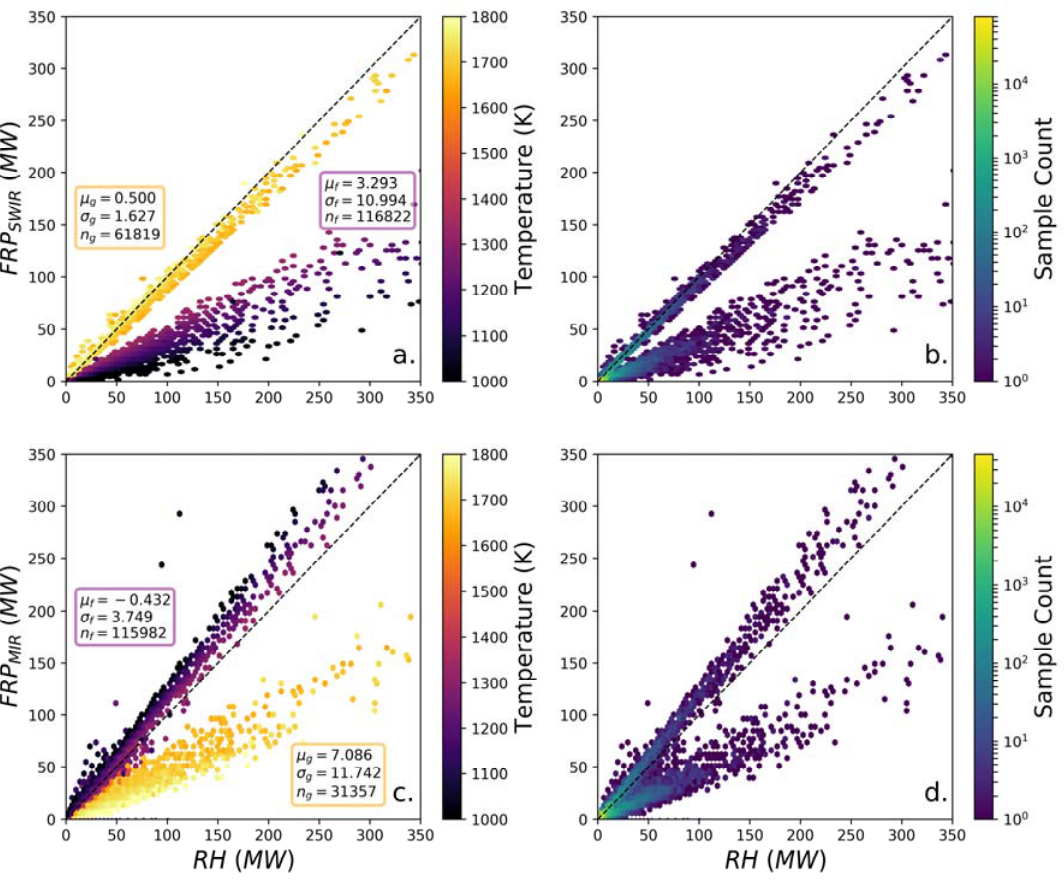
Figure 6. Comparisons of night-time detected hotspot pixel radiative power outputs, calculated using either the SWIR-Radiance method developed herein (FRP SWIR ; y -axis; plots ( a ) and ( b )) or the MIR-Radiance method of [1,2] (FRP MIR ; y -axis; plots ( c ) and ( d )) and the radiative heat flux (RH, x -axis) measure based on application of the NightFire algorithm [20] using Plank function fitting. Data cover Africa and the Middle East in February and September 2015, as shown in Figure 5. The left-hand plots ( a , c ) represent the mean sub-pixel effective temperature of the hotspots present at each point on the scatterplot. The inset coloured boxes present statistics associated with the similarly coloured data points, with the subscript f denoting assumed biomass burning (650 K ≤ T ≤ 1300 K) and g denoting assumed gas flaring (1600 K ≤ T ≤ 2200 K). Right hand plots ( b , d ) show that each location on the scatterplot is typically composed of the results from multiple sub-pixel hotspot detections, particularly at lower radiative power output values.